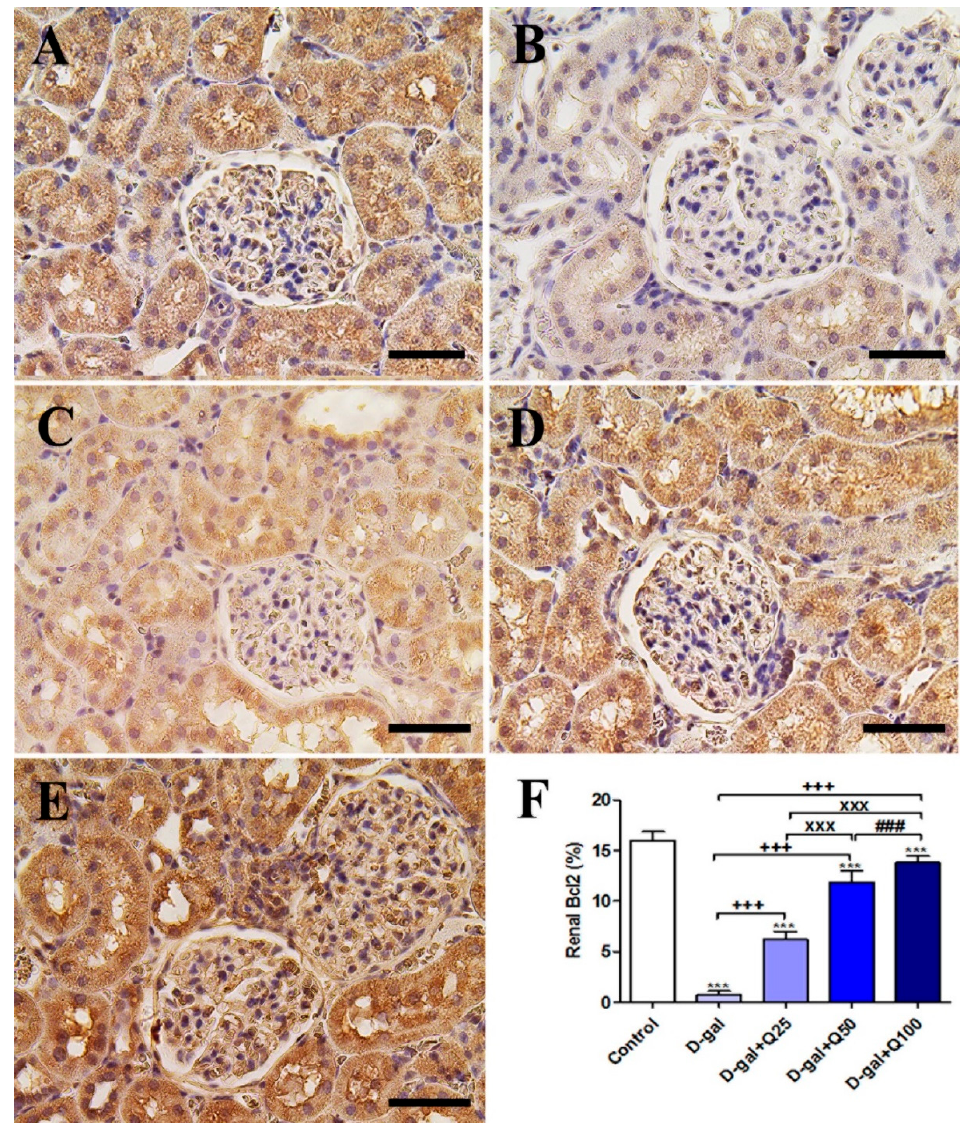
Figure 10. Immunohistochemical staining of rats’ kidney with B-cell lymphoma 2 (Bcl2). ( A ) Negative control group. ( B ) D-gal group. ( C ) D-gal + Q25 group. ( D ) D-gal + Q50 group. ( E ) D-gal + Q100 group. ( F ) Quantification of Bcl2 in the renal tissues in different groups. Scale bar = 50 µm . Data were analyzed with one-way ANOVA followed by Tukey’s multiple comparison test. *** p < 0.001 vs. control. +++ p < 0.001 vs. D-gal. xxx p < 0.001 vs. D-gal + Q25. ### p < 0.001 vs. D-gal + Q50. Error bars represent mean ±